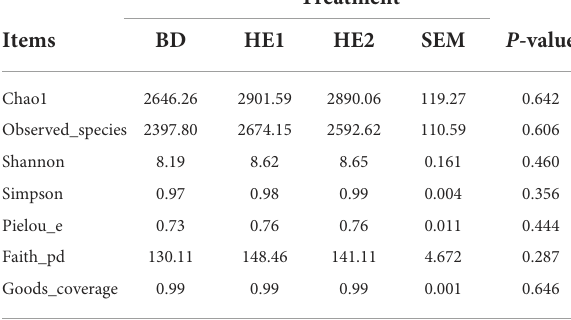
TABLE 6 Effect of HE on α -diversity a